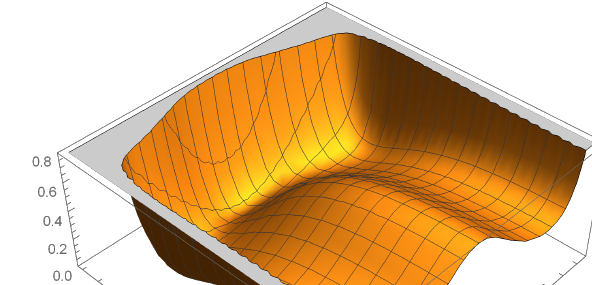
( b ) Figure 1. The scalar potential V / M 2 with δ = 0, γ = 1, and ζ = − 1.7774, from the two perspectives ( a ) and ( b